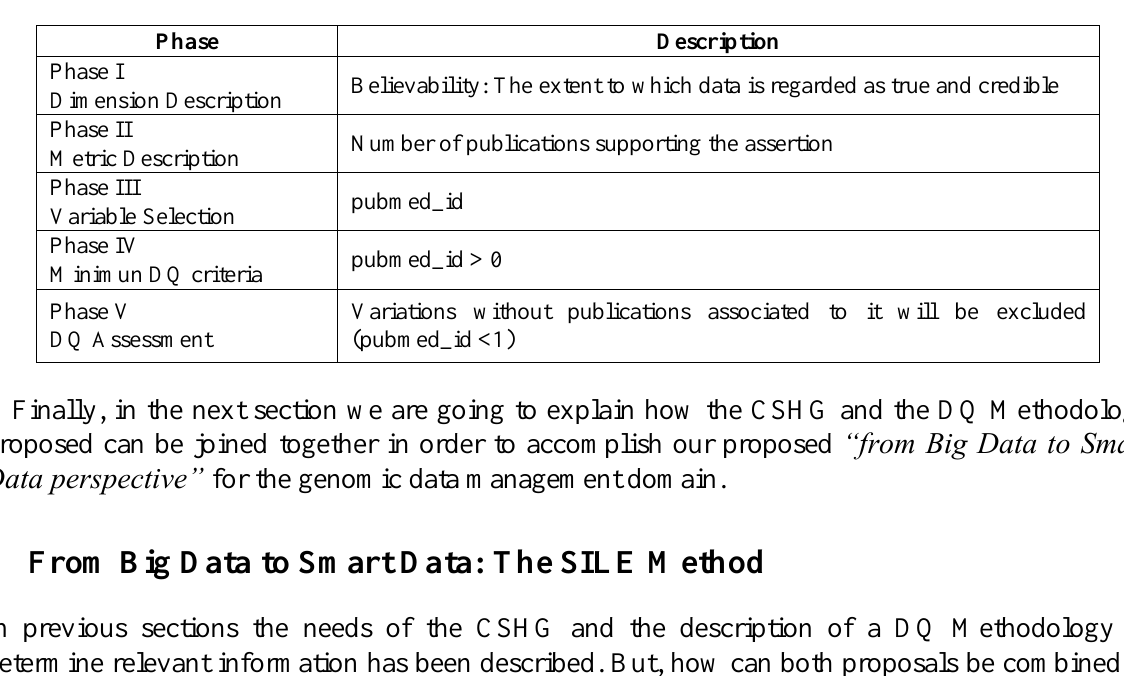
Table 3. Example of how to determine the believability of a variation